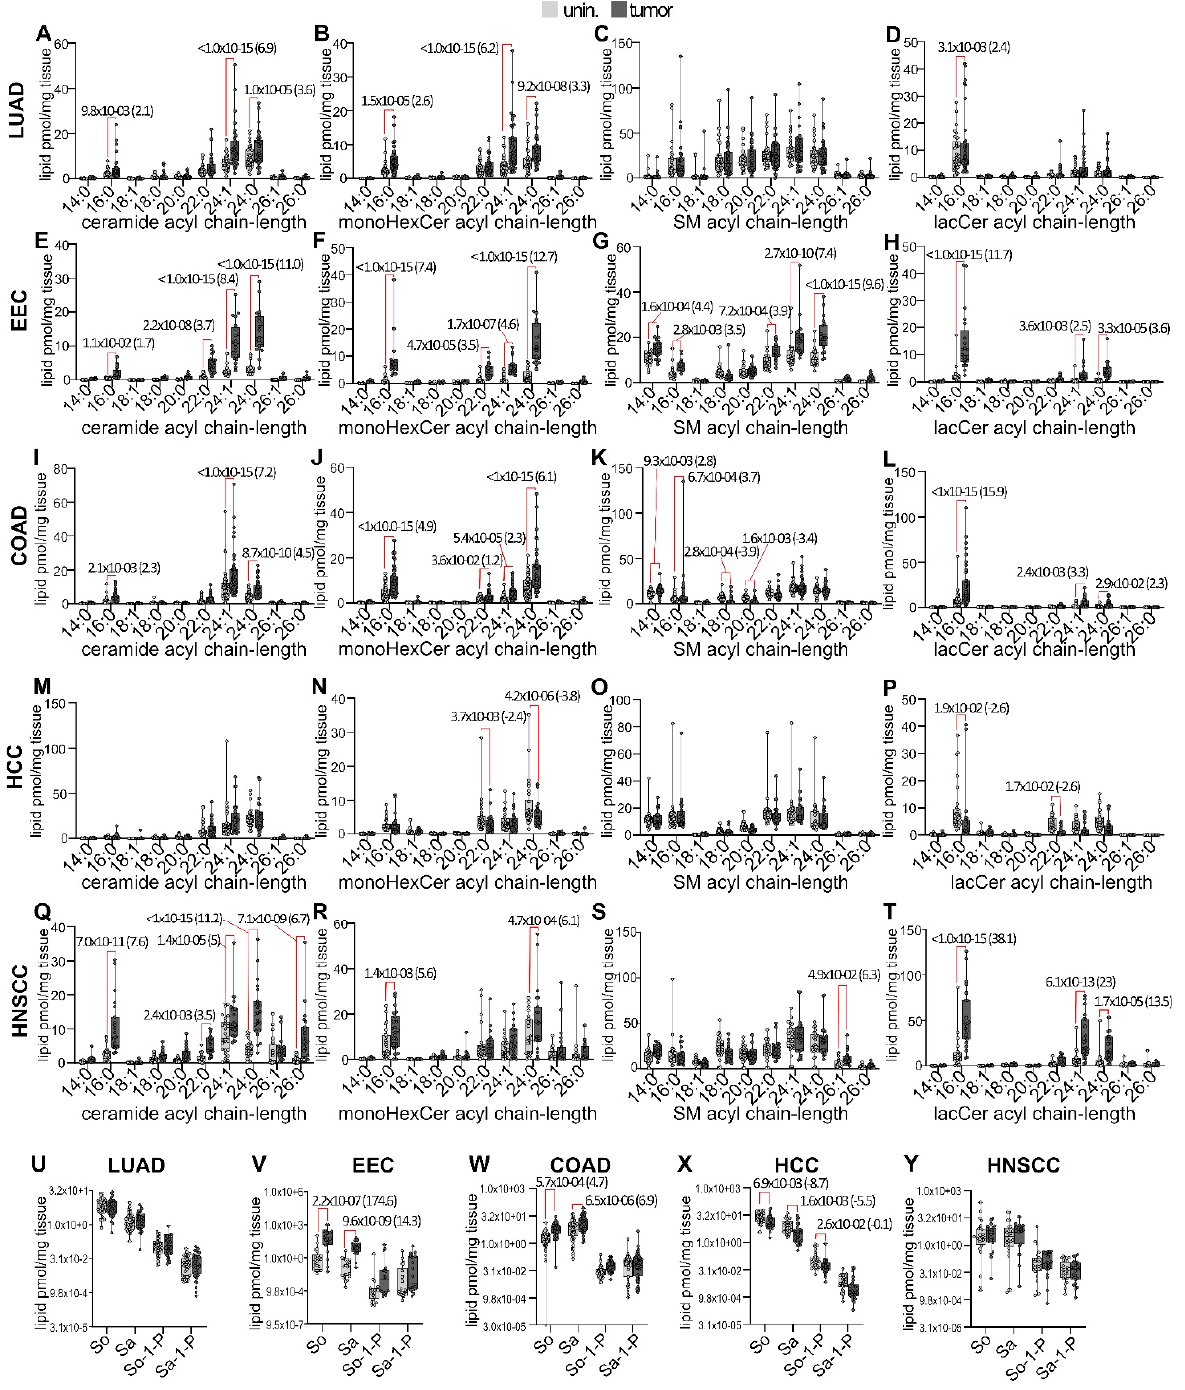
Figure 1. Sphingolipid profiles of normal adjacent uninvolved tissues and tumors of male patients diagnosed with LUAD, COAD, HCC, and HNSCC and of female patients with EEC. The indicated chain-length sphingolipids were quantified by LC-ESI-MS/MS in normal adjacent uninvolved tissues (unin.) and tumors of self-identified AA and NHW subjects (data combined in plots) with primary histopathologic confirmed diagnoses of lung adenocarcinoma (LUAD; panels ( A – D , U )),